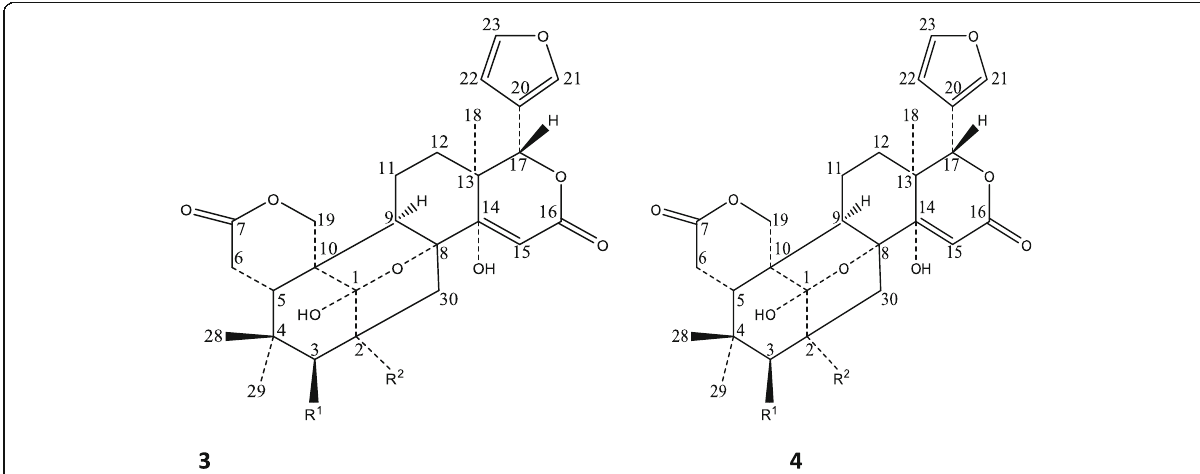
Fig. 7 Structure of limonoids from the stem bark of K. anthotheca (3) 3- O -acetylanthothecanolide. R 1 = OH, R 2 = OH. (4) 2,3-di-O- acetylanthothecanolide. R 1 = OA C , R 2 = OH. Adapted from